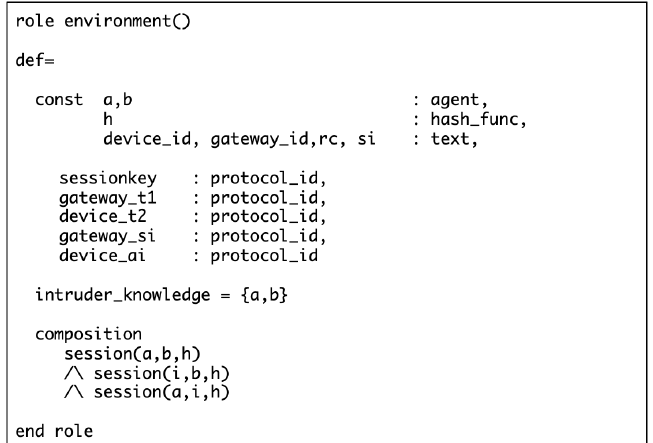
Figure 12. Specification of the environment role.